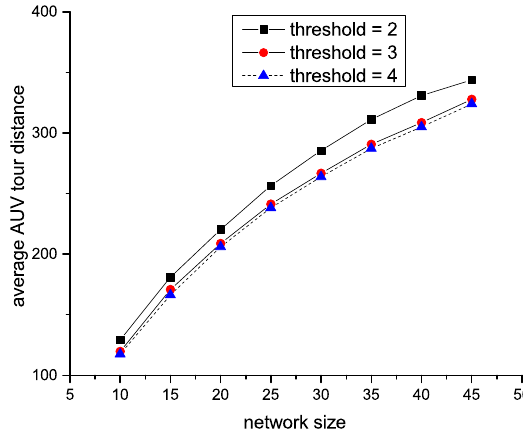
Figure 10. Effect of parameter l in distributed HAS 4 on